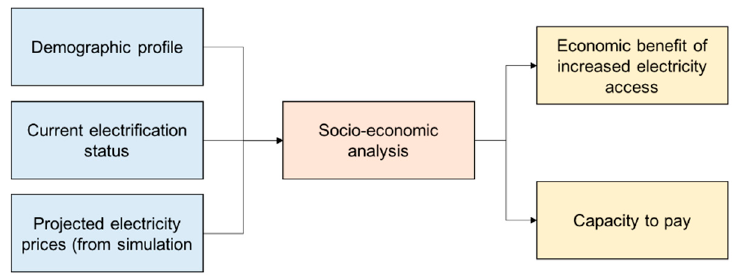
Figure 3. Framework for socio-economic viability